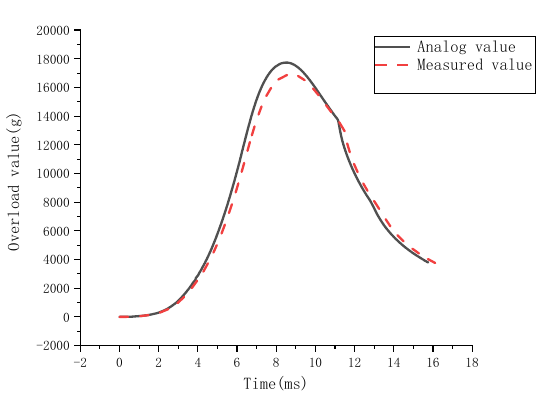
Fig. 1. Comparison between the test overload curve of artillery and the simulation overload curve .